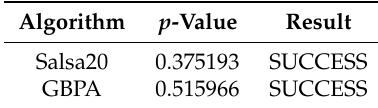
Table 7. p -values returned by the EACirc framework when evaluating sequences generated by Salsa20 and GBPA.